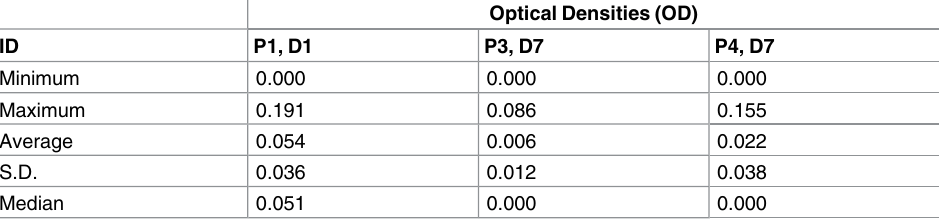
Table 4. Statistics applied to optical densities obtained with the E rns –based Ag ELISA on 68 field negative samples, according to the protocol (P) and day (D) used. Optical Densities (OD) ID P1, D1 P3, D7 P4, D7 Minimum 0.000 0.000 0.000 Maximum 0.191 0.086 0.155 Average 0.054 0.006 0.022 0.036